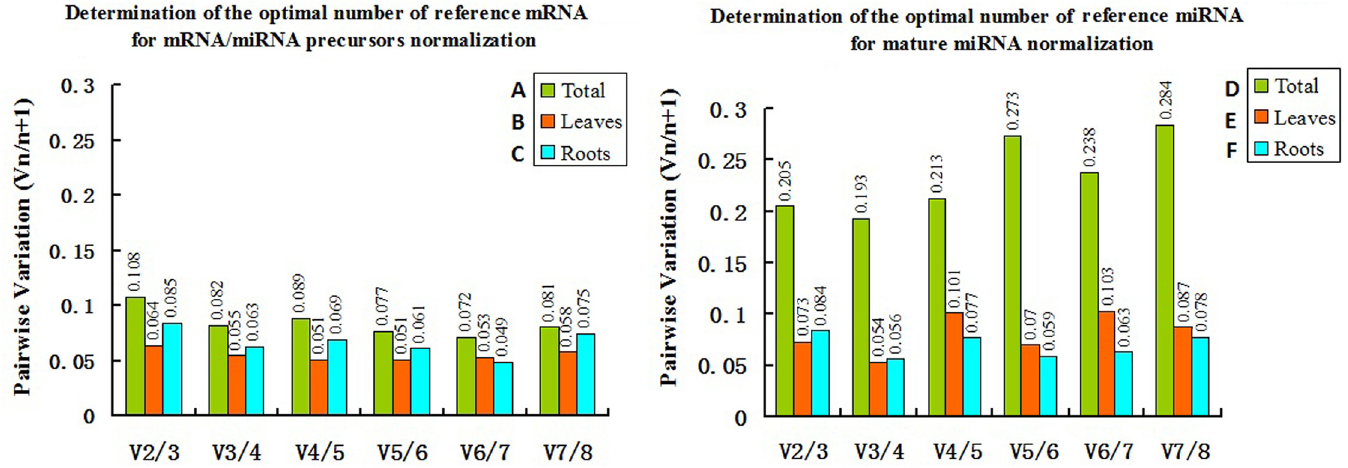
Fig 3. Determination of the optimal number of reference mRNAs and candidate reference miRNAs for normalization according to pairwise variation (V n/n+1 ) using geNorm. V n/n+1 > 0.15 indicated an additional (n + 1) reference was required while V n/n+1 (cid:2) 0.15 indicated an additional reference was not required. The six tested groups are the same as those indicated in Fig 1 (Group A to